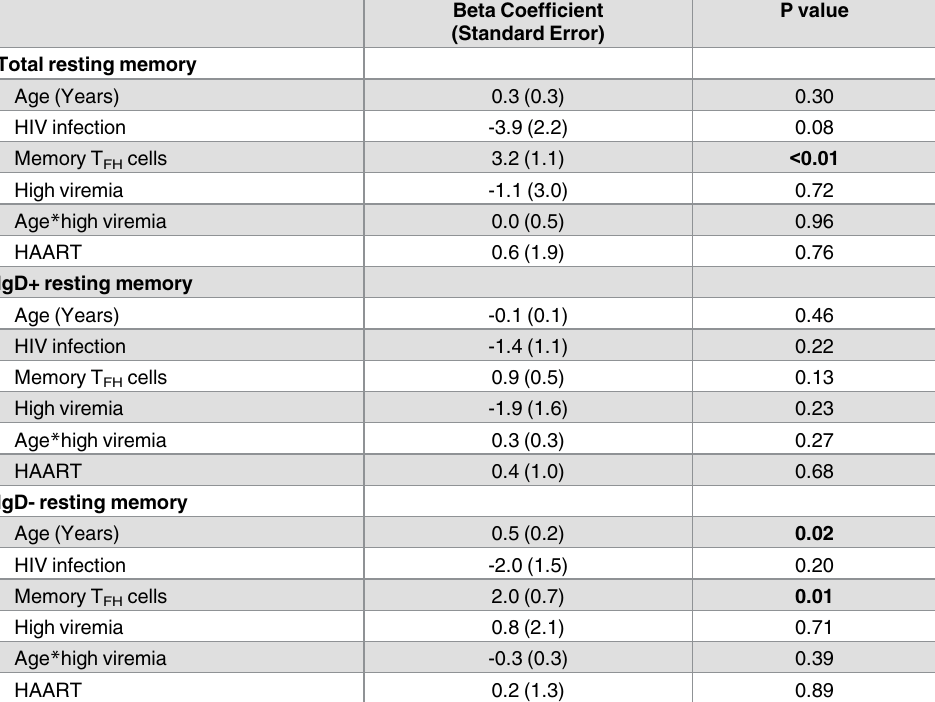
Table 2. Estimatedchange (beta coefficients) in frequencies of memory B-cell subsets with variations in age, HIV status, proportions of memory T FH cells, viremia and HAART in multivariable